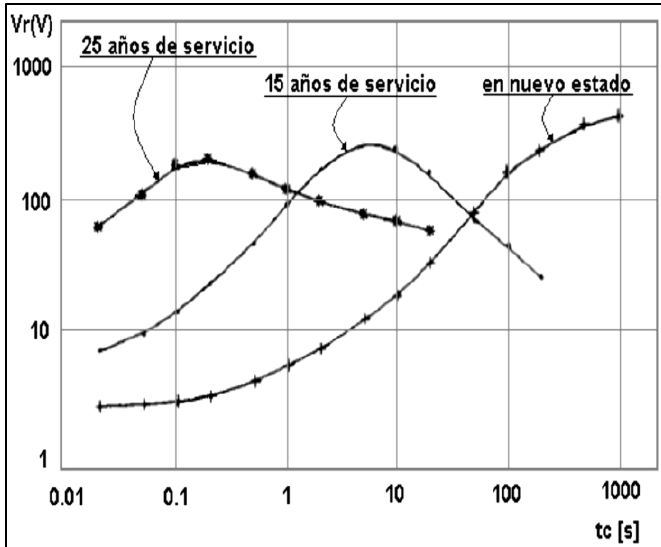
Figura 7: Curvas RVM de transformadores de edades diferentes. Fuente: Autores,